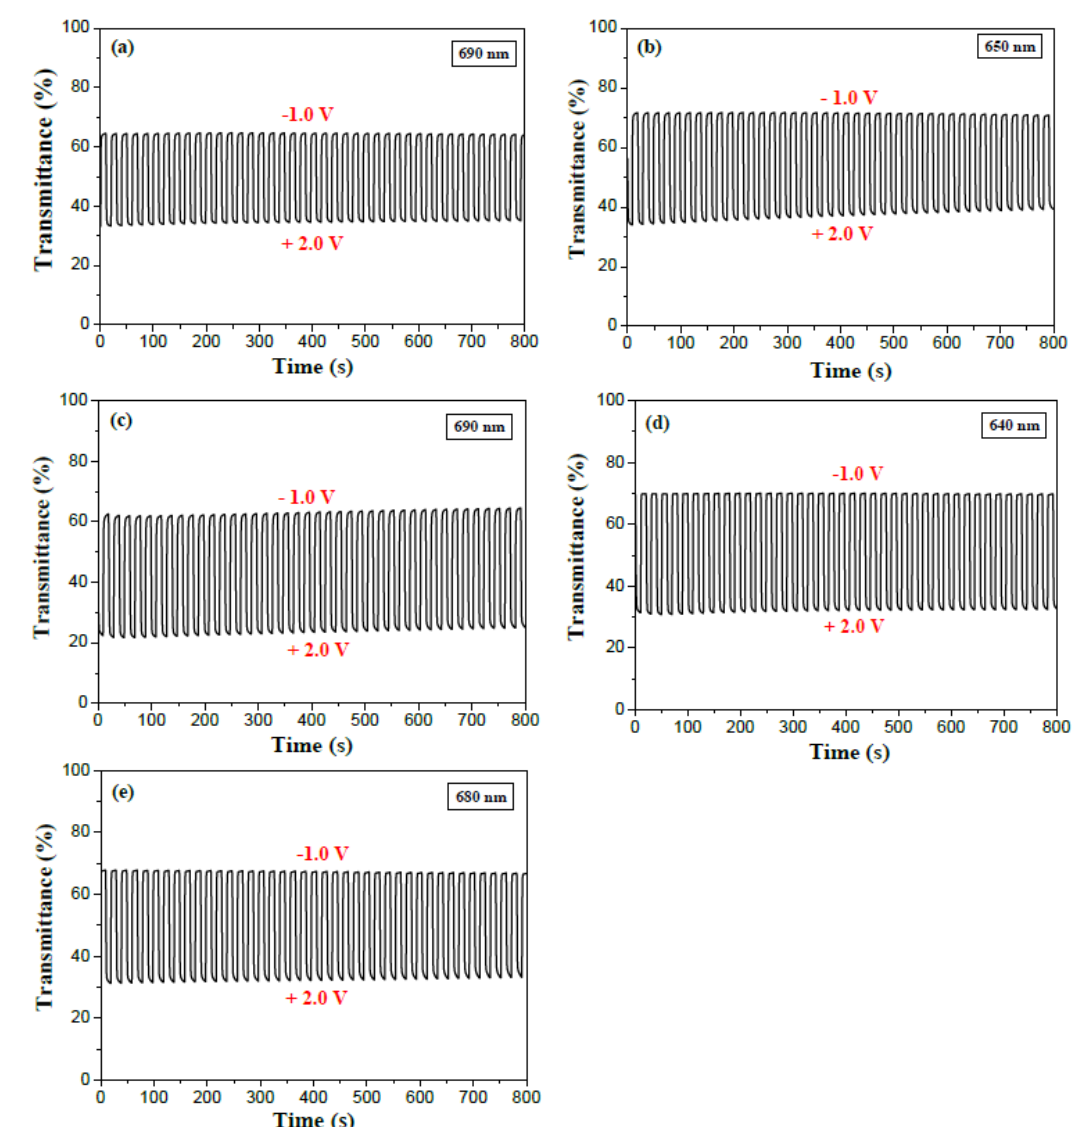
Figure 8. Switching profiles of the ( a ) P(DCB)/PEDOT-PSS, ( b ) P(DCB- co -ED)/PEDOT-PSS, ( c ) P(2DCB- co -ED)/PEDOT-PSS, ( d ) P(DCB- co -EDm)/PEDOT-PSS and ( e ) P(2DCB- co -EDm)/PEDOT- PSS devices.